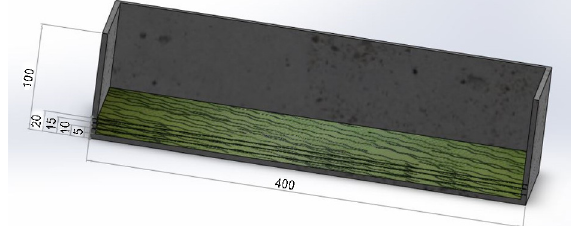
Fig. 4. Group 3 specimens scheme (is shown warps location and fibers orientation in them, in the specimen)